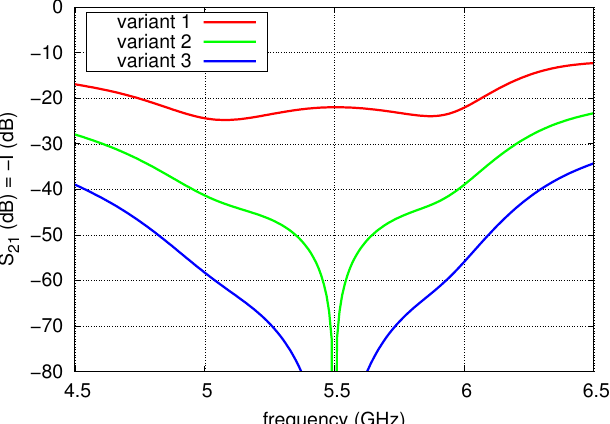
Figure 5. Isolation of the array for three considered variants of the feeding